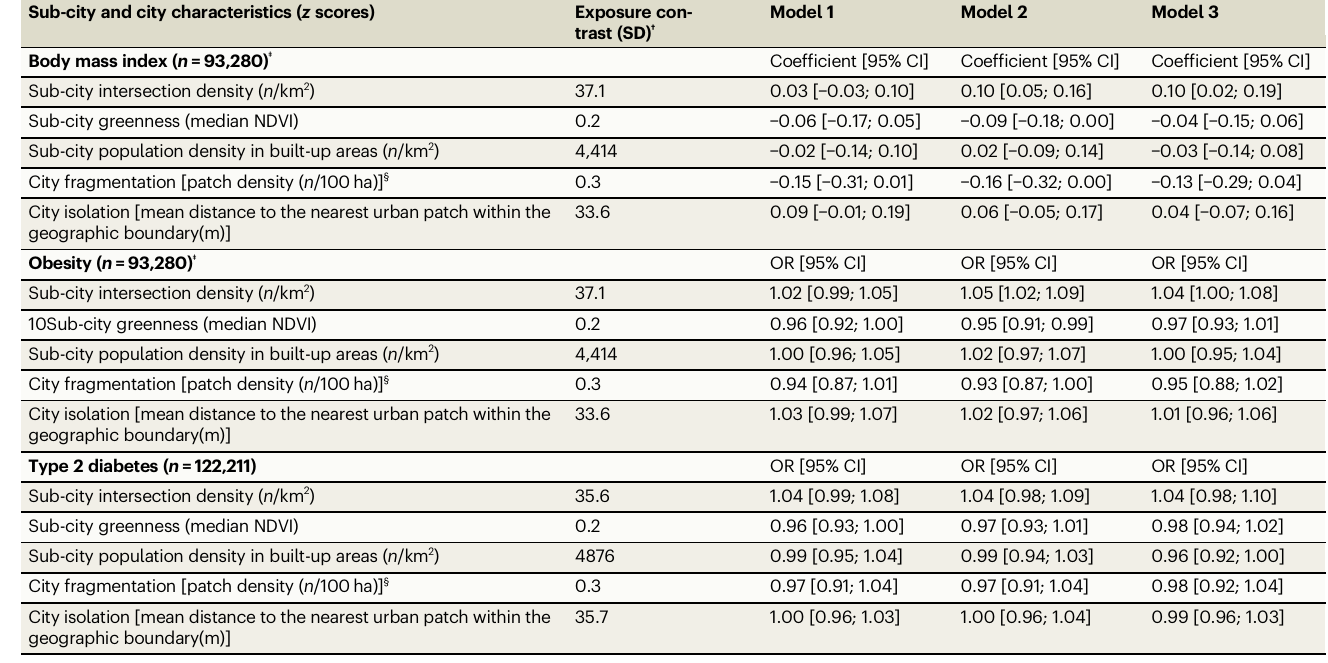
Table 2 | Associations between sub-city and city exposures and BMI, obesity, and type 2 diabetes Sub-city and city characteristics ( z